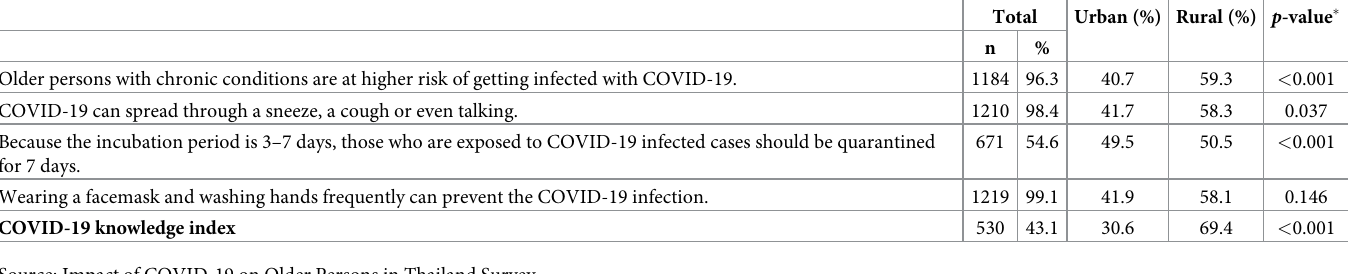
Source: Impact of COVID-19 on Older Persons in Thailand Survey. � Based on χ 2 test comparing urban and rural residence.